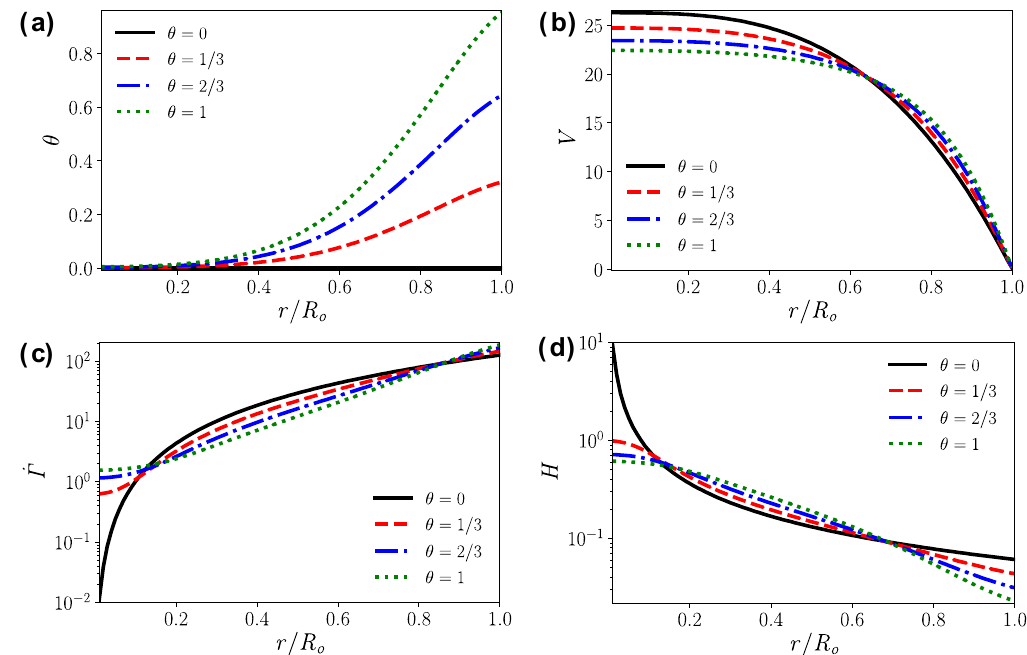
Figure 7. Dimensionless ( a ) temperature, ( b ) velocity, ( c ) shear rate and ( d ) apparent viscosity profiles in the radial direction at the outlet for di ff erent wall temperatures. The inlet mean velocity, mean shear rate and mean apparent viscosity with θ w = 1 and Re gen = 2.3 × 10 − 2 are used as reference parameters.